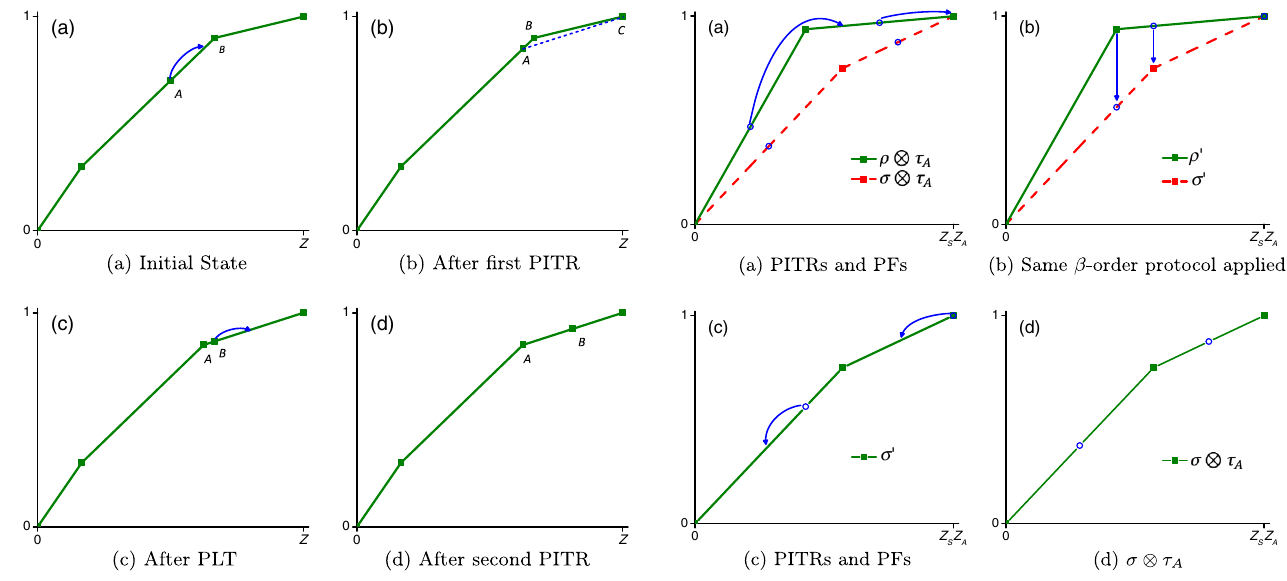
FIG. 9. Approximate points flow. Here we illustrate the pro- tocol of approximate points flow using thermomajorization diagrams. Initially the system is as per (a). Using a PITR, the nonelbow point A is moved towards the elbow at point B . This results in (b). Next, a PLT is applied between points A and C , leading to (c). Point B is now a nonelbow and can be moved using a PITR, giving (d).